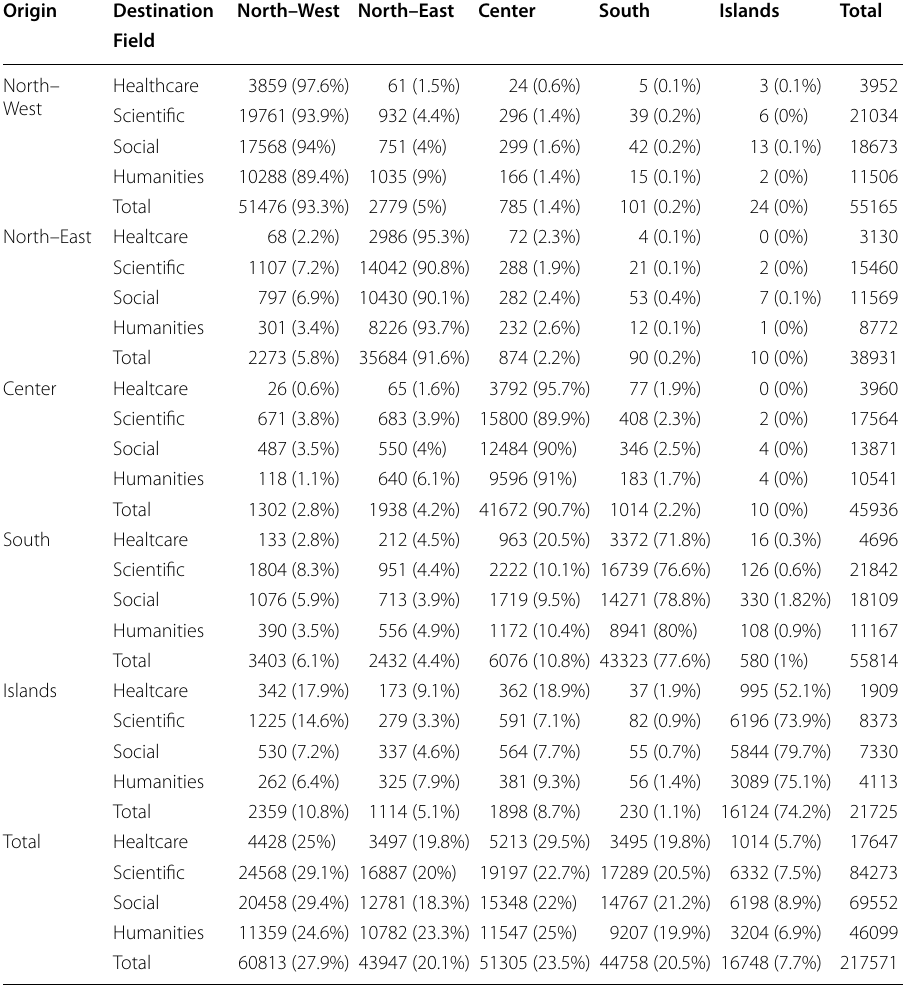
Table 2 Freshmen in 2014–2015 for macro-area of origin, disciplinary field of study, and macro-area of destination. The percentages are relative to the